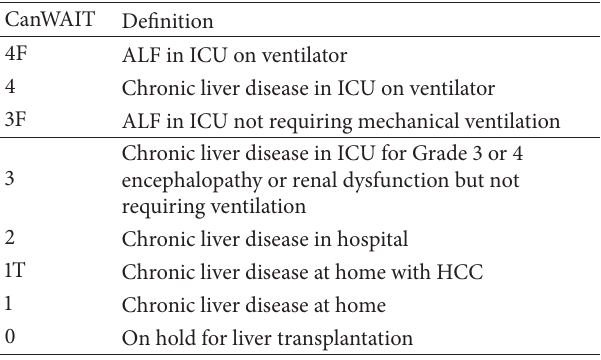
Table 1: Child Pugh (CP) classification.